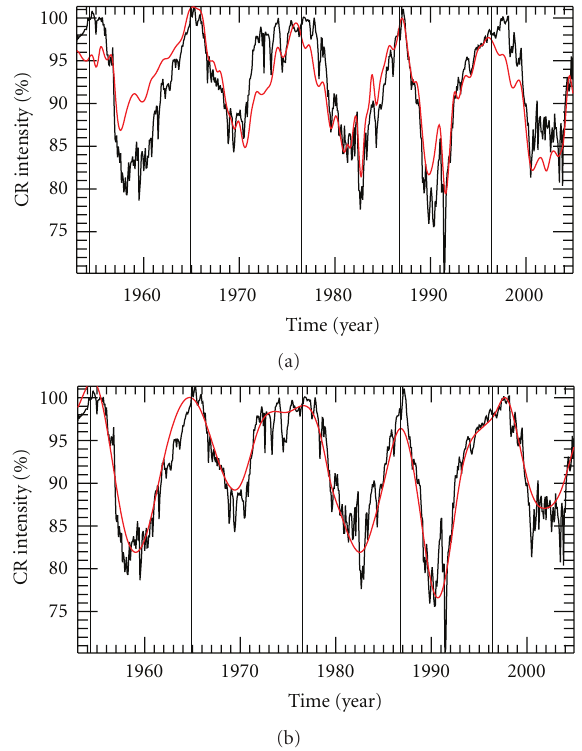
Figure 7: (a) CR intensity (black line), superposition (red line) of the ∼ 11 yr mode, and the QBOs computed from CLI data. (b) CR intensity (black line), superposition (red line) of the ∼ 11yr and modes s 7 and s 9 computed from CLI data. Dashed vertical lines indicate the time of the solar min- ima as provided by ftp://ftp.ngdc.noaa.gov/STP/SOLAR DATA/ SUNSPOT NUMBERS/docs/maxmin.new.